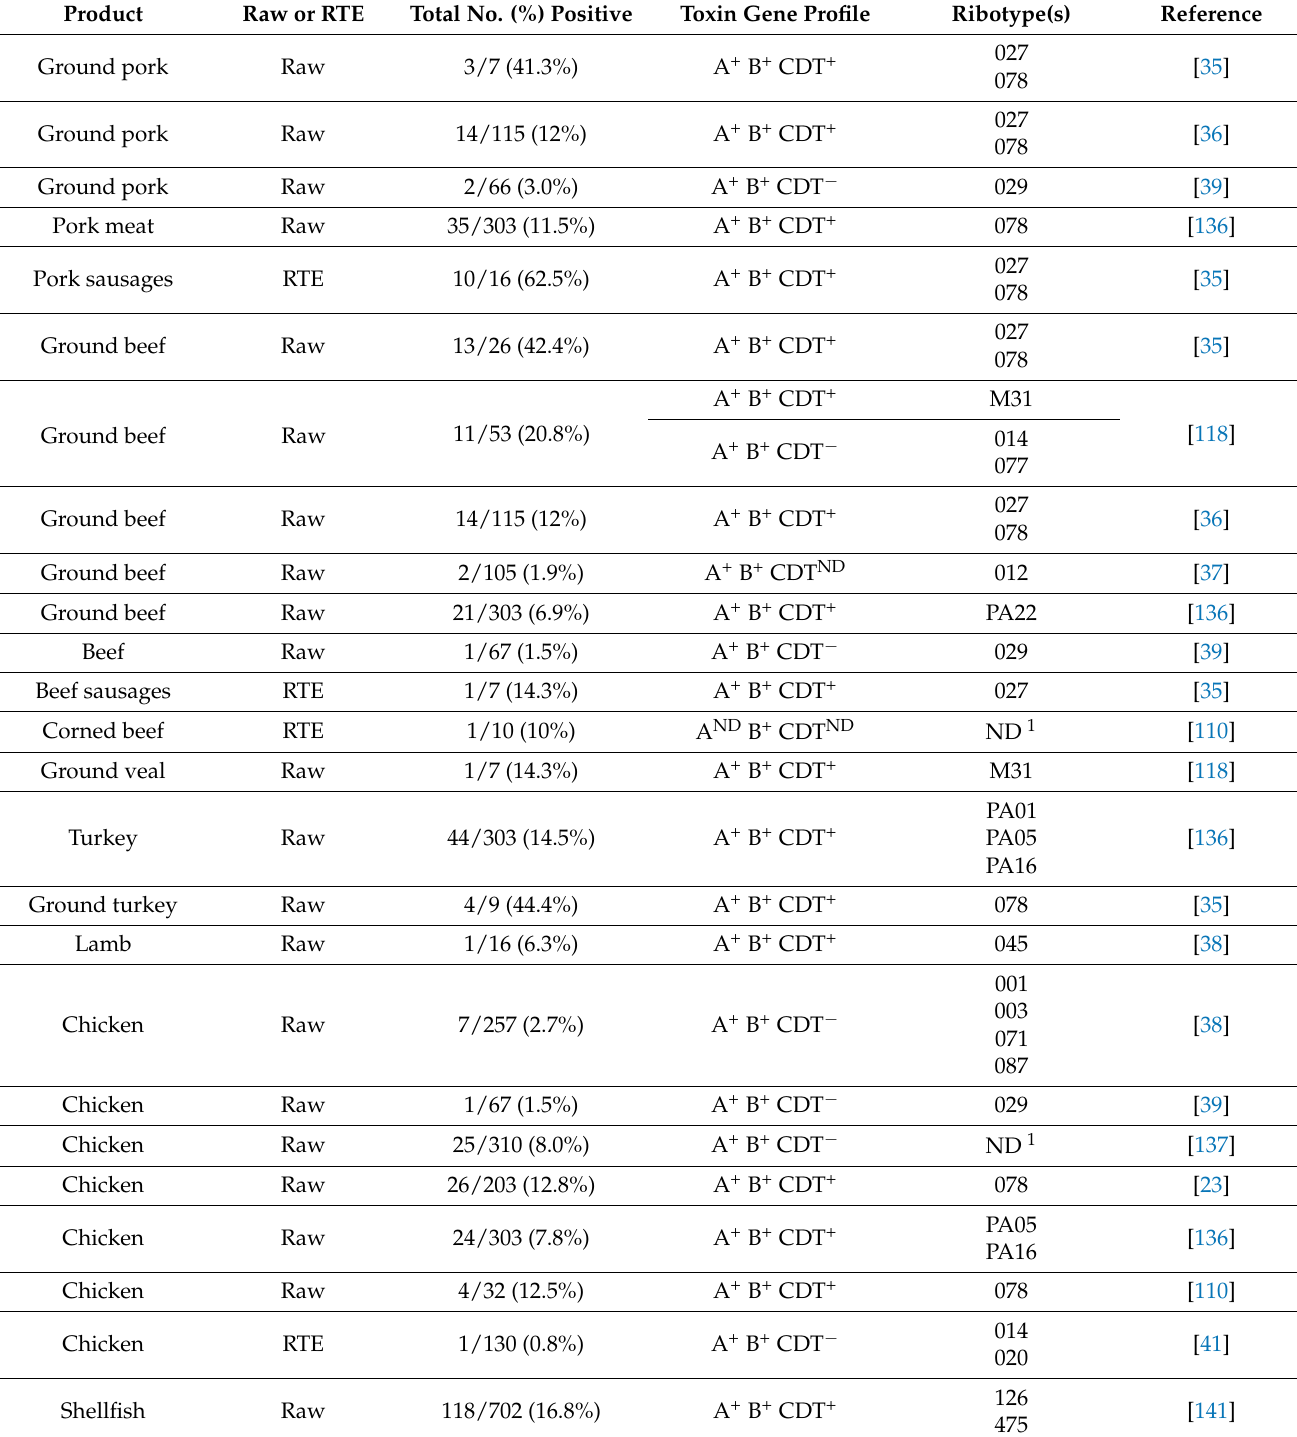
Table 2. Meat and seafood retail foods contaminated with C. difficile , including toxin gene profiles (toxins A, B and CDT) and